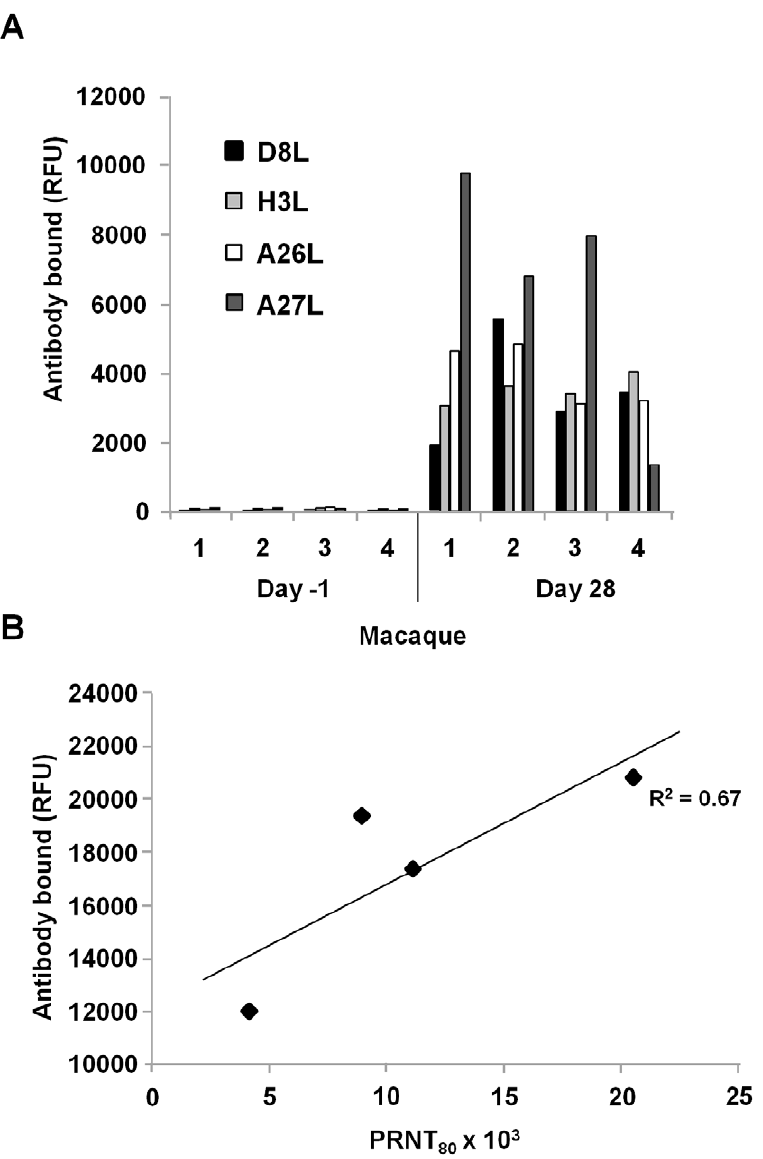
Figure 2. IgG responses to ZAIRE IMV envelope proteins contribute to virus neutralization. (A) Antibody binding at days -1 and 28 relative to viral challenge in four macaques (1–4). Mean RFUs of 2–4 protein spots (SD , 15%). (B) Correlation between IgG binding to IMV and serum neutralizing activity. Total antibody binding level to the IMV surface was estimated as the sum of fluorescent intensities for A26L, A27L, D8L, and H3L and analyzed for association with PRNT80 using linear regression.